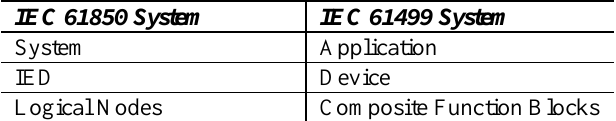
Table 2. Mapping of IEC 61850 artefacts to IEC